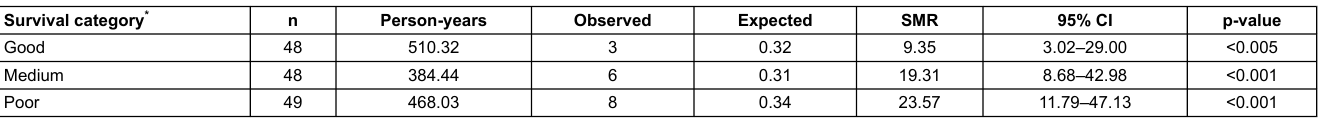
Table 4: Standardised mortality ratios (SMRs) for breast cancer among relatives according to survival risk category. Survival category